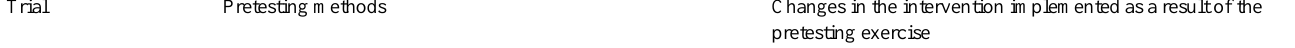
exercisePretesting methodsTrial